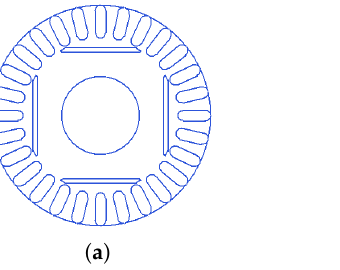
Figure 29. Three designs chosen from the DE optimization results for comparison: ( a ) design 1, ( b ) design 2, ( c ) design